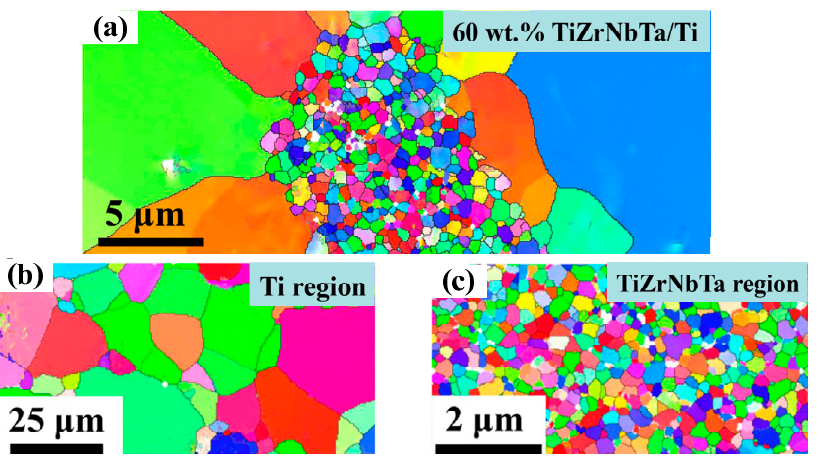
Figure 5. EBSD maps of the optimized TiZrNbTa high entropy alloys/Ti composites ( a ), EBSD maps of Ti-matrix region ( b ) and EBSD maps of TiZrNbTa region ( c ) [51]. Reprinted with permission from Ref. [51]. Copyright 2017, Mat. Sci. Eng. A.